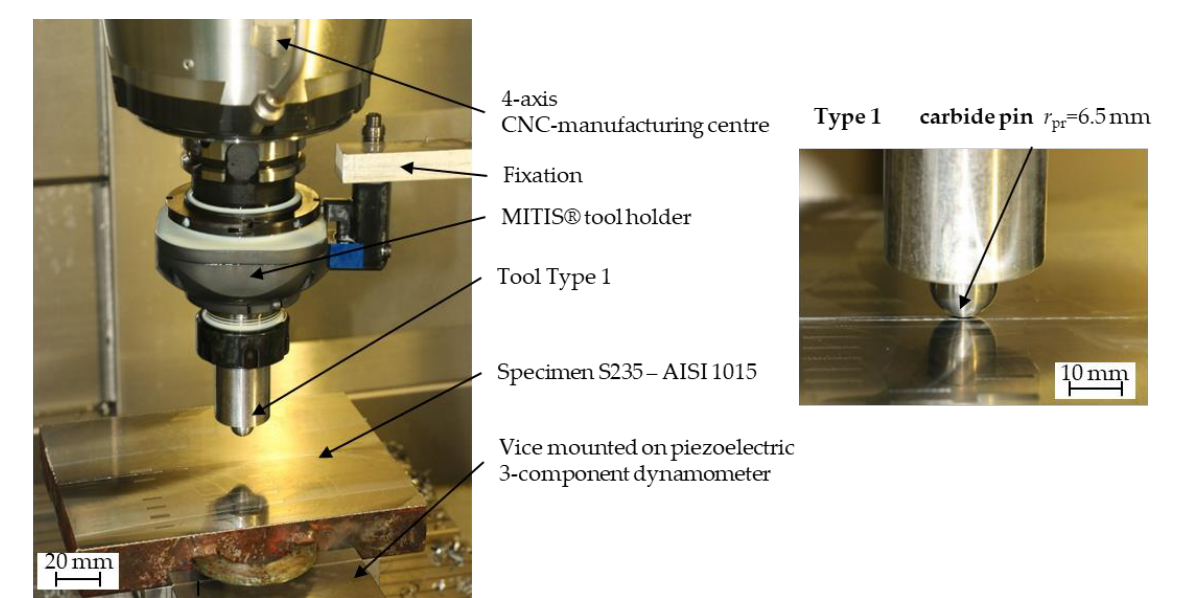
Figure 3. Experimental setup (left) and details of the used tools type 1.